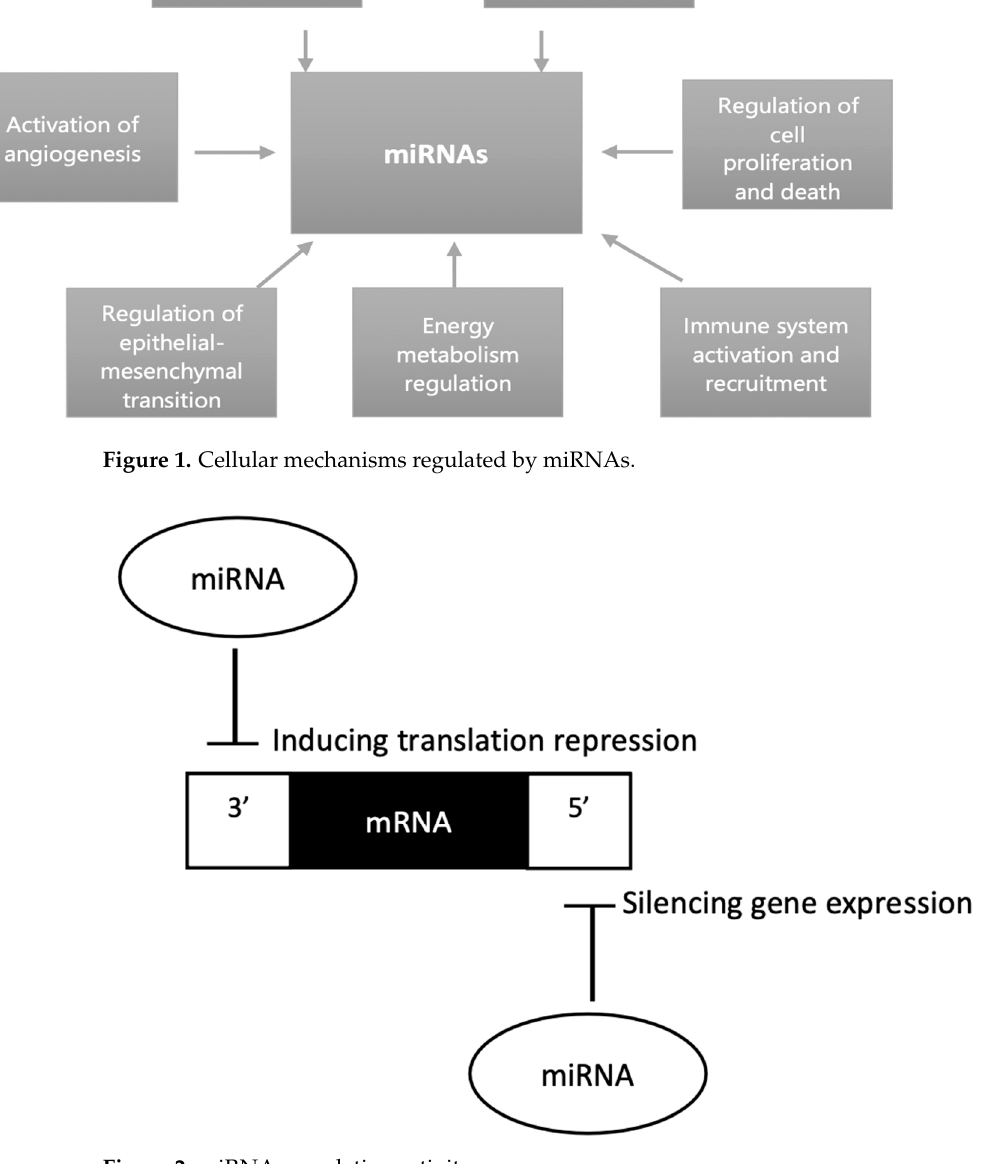
Figure 2. miRNAs regulation activity.